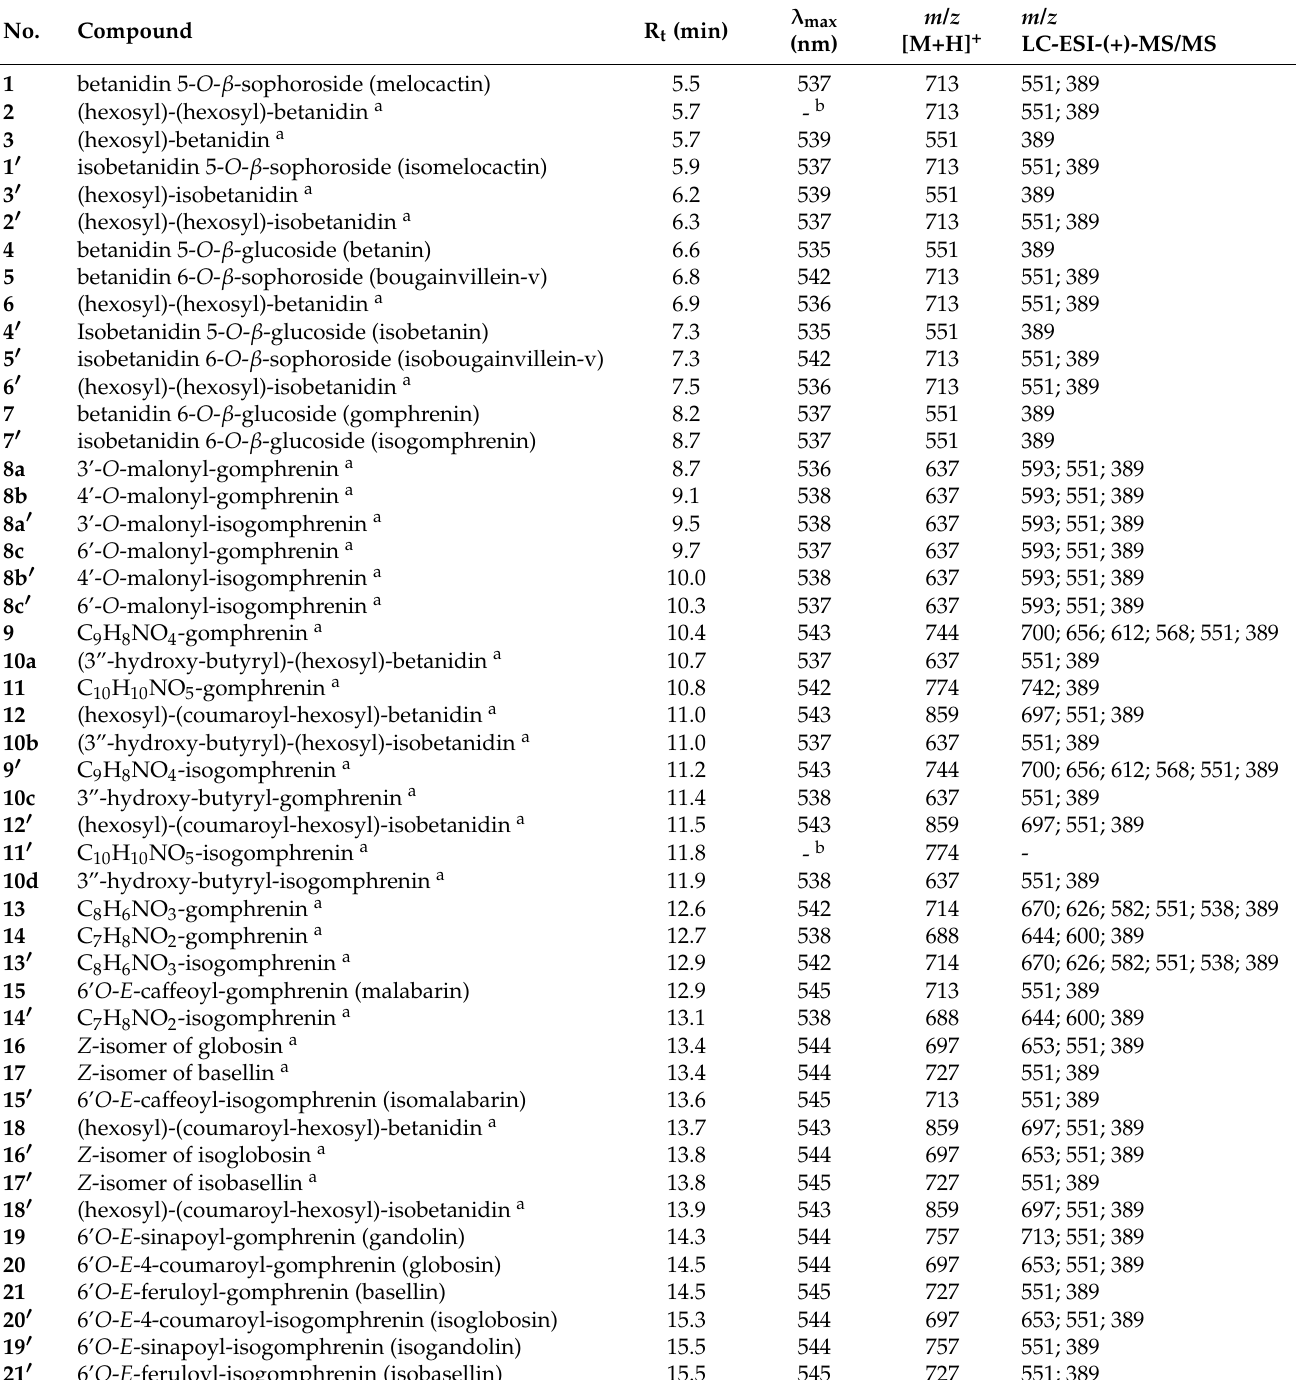
Table 1. Chromatographic, spectrophotometric and mass spectrometric data of the analyzed beta- cyanins detected in B. alba and B. alba var. ‘ Rubra ’ fruit